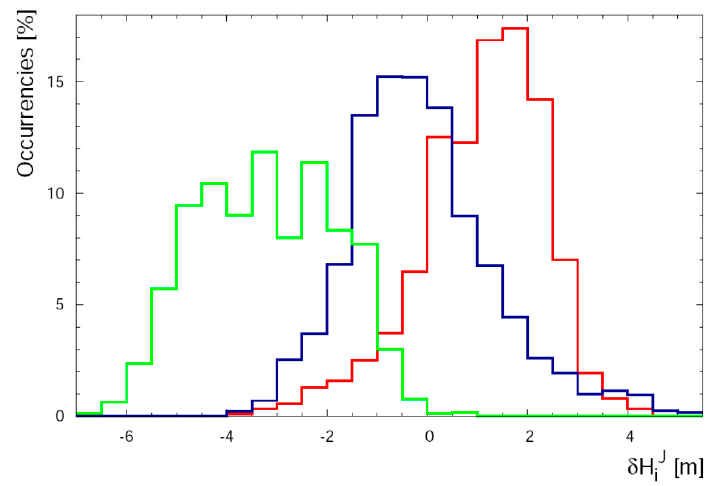
J H δ in the (464–2194) m range of altitude: GPSIMU dataset in the (464–2194) m range of altitude: GPSIMU dataset in i i